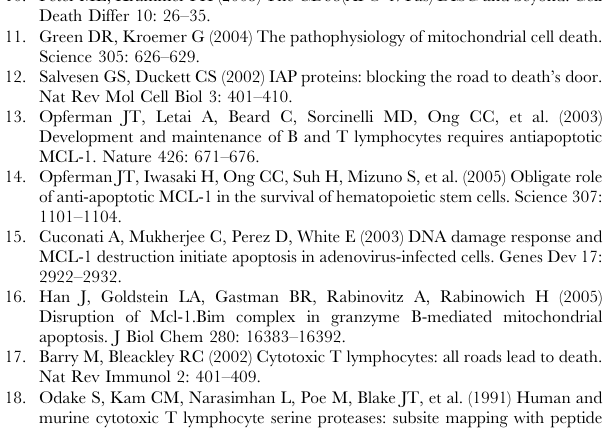
Figure S4 HeLa cells were infected for 30 h and the expression of BIM, BID, BAD and PUMA was checked by immunofluores- cence analysis. Shown are the images from one representative field (20 6 ). The Overlay of the green and phase contrast images revealed that despite the presence of Chlamydial inclusions, there is no alteration in the expression levels of these proteins. Figure S5 Quantification of immunoblots shown in Figure 4A. The immunoblots of BID (A), BAD(B), BIM (C) and PUMA (D) were quantified as described in the supporting methods. Shown are the data from one representative experiment. Found at: doi:10.1371/journal.pone.0003102.s006 (0.31 MB TIF) Figure S6 MEK-1 and PI3K involved in the regulation of cIAP- 2 protein levels. Cells were infected with C. trachomatis and the MAPK inhibitors U0126 (10 and 100 m M) and LY294002 (31, 62, 125 m M) were added. The cells were then lysed at 20 h post infection and the protein levels of cIAP-2, active AKT and ERK were monitored by immunoblot analysis. Prohibitin was used as a loading control. Figure S7 Enlarged presentation of the Smac immunofluorens- cence images shown in figures 5A and 5B. Found at: doi:10.1371/journal.pone.0003102.s008 (6.51 MB